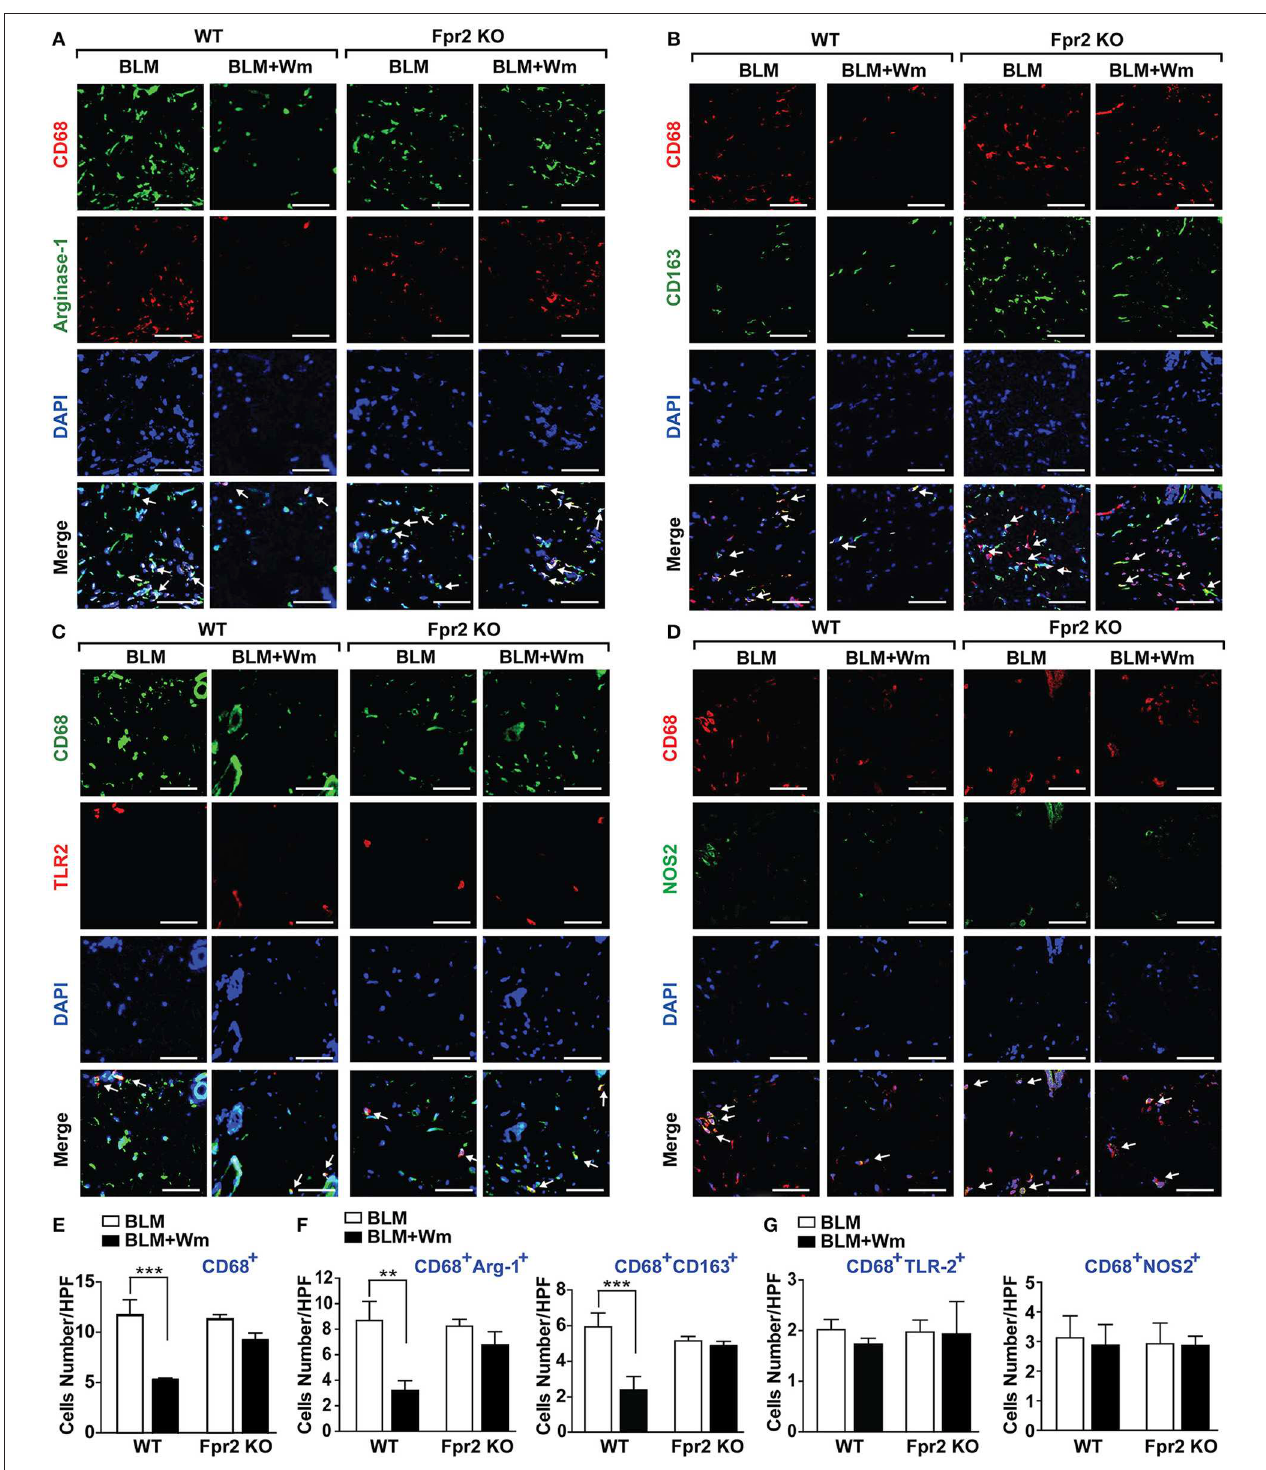
FIGURE 7 | The role of Fpr2 in WKYMVm-induced decrease of M2 macrophages in scleroderma skin. The BLM-induced scleroderma skin of wild type and Fpr2 KO mice were injected with or without Wm for 3 weeks, followed by staining with anti-CD68 antibody together with anti-Arginase-1 (A) , anti-CD163 (B) , anti-TLR2 (C) , or NOS2 (D) antibodies. Nuclei was stained with DAPI and overlaid images are shown. Scale bar = 50 µ m. The numbers of CD68 + macrophages (E) , M2 type macrophages ( F : CD68 + Arginse-1 + and CD68 + CD163 + cells), M1 type macrophages ( G : CD68 + TLR2 + and CD68 + NOS2 + cells) were counted under high-power field. Data represent mean ± SD ( n = 8 per group). ** p < 0.01, *** p < 0.001.